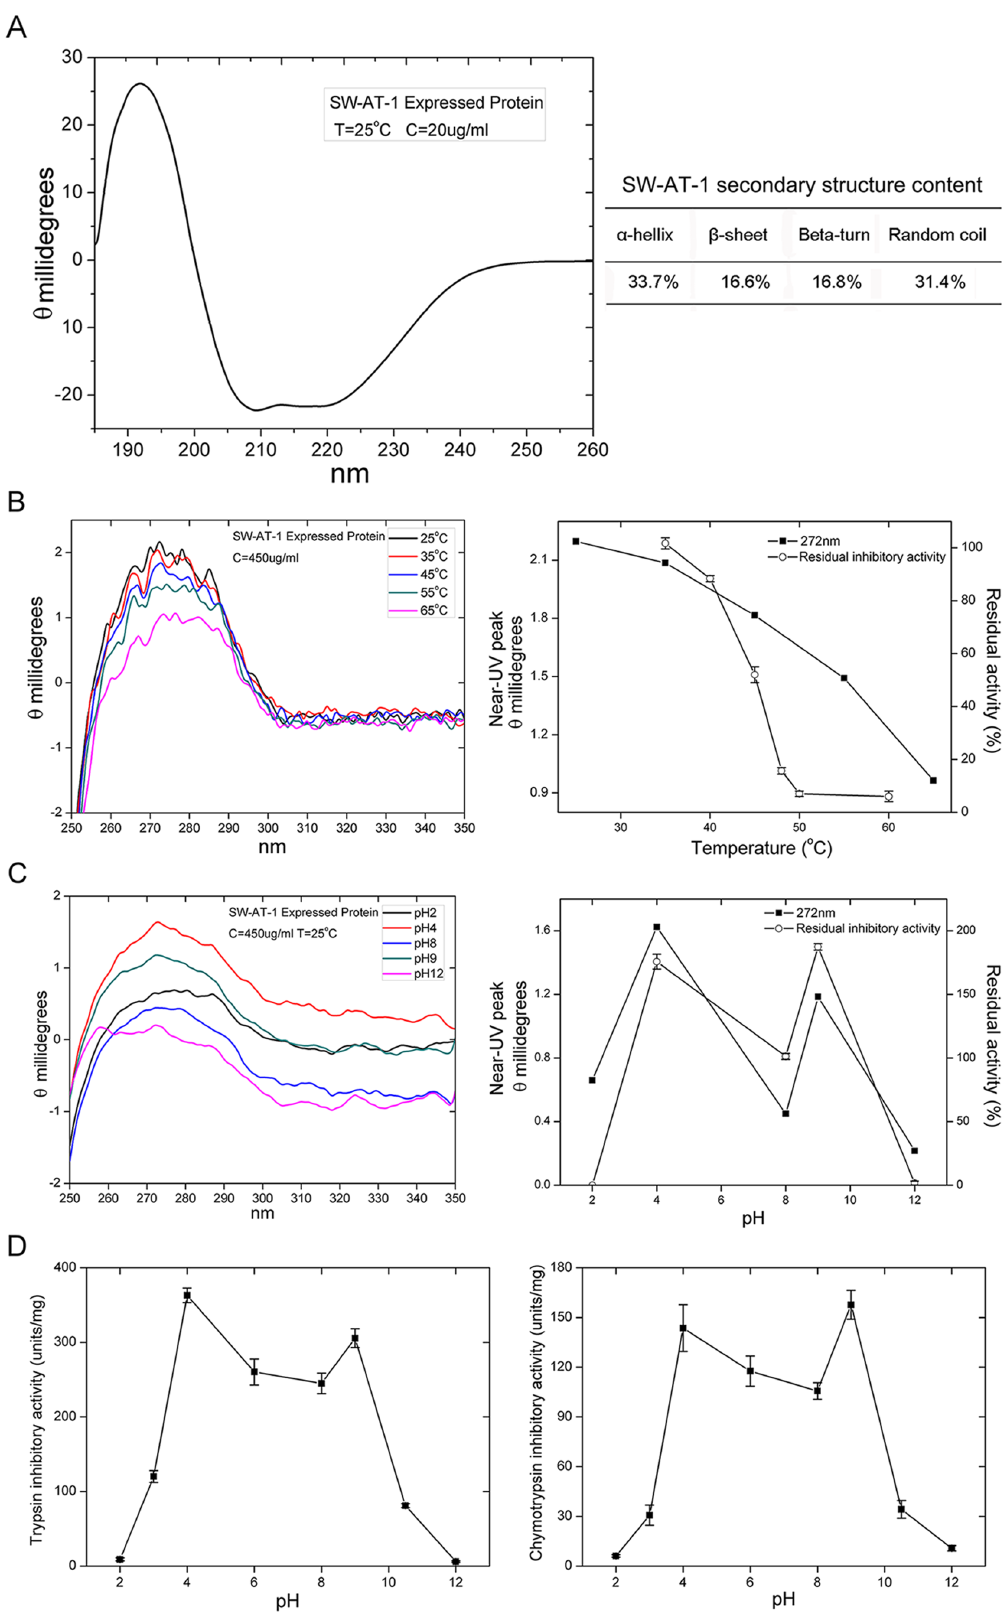
Figure 4. Characterization of SW-AT-1. (A) far-UV CD spectra of rSW-AT-1(left panel) and secondary sructure content (right panel); (B) near-UV CD spectra of rSW-AT-1 at different temperatures (left panel) and maximum aborbance 272-nm and trypsin inhibitory activity at different